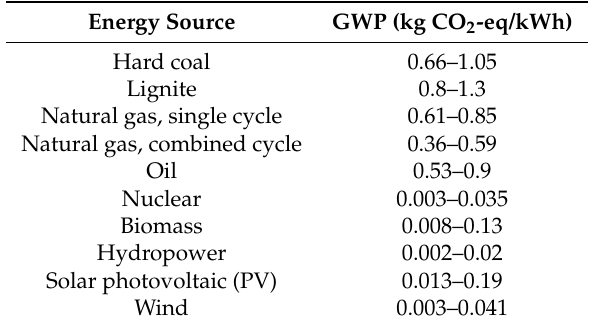
Table 3. Emission factors of power production technologies. Extracted from [43].